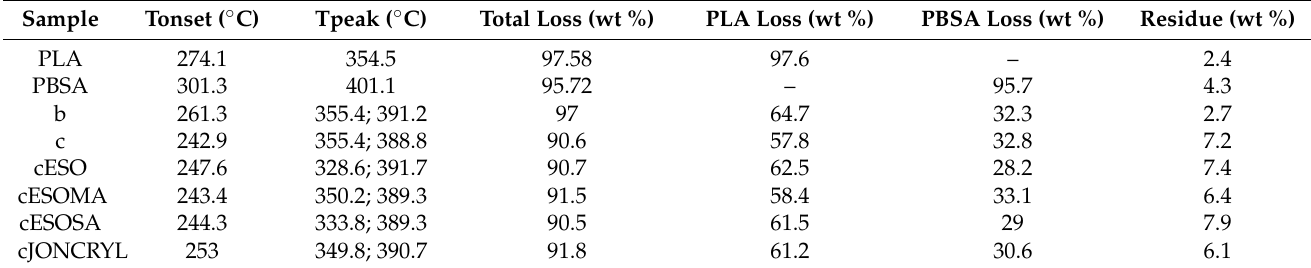
Table 7. TGA results for pure PLA and PBSA and for F1, F2, F3, F4, F12, and F16